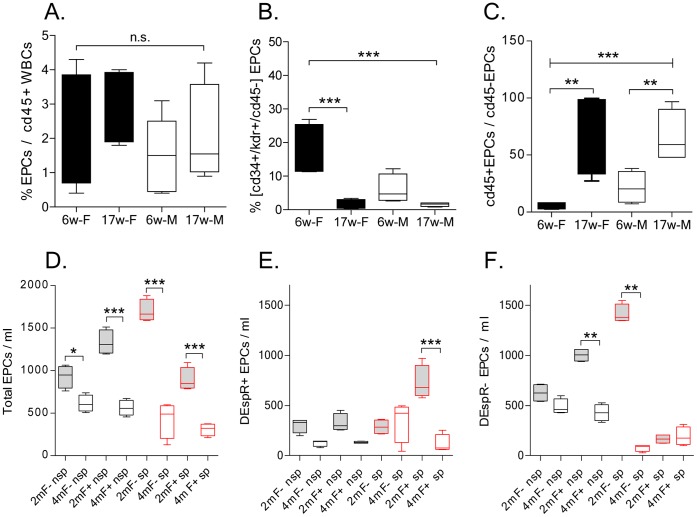
FACS analysis of age- and sex-specific changes in cd34+/kdr+ EPC subtypes. A) Analysis of the ratio of cd34+/kdr+ EPCs to cd45+ white blood cells as %, in males (M) compared to females (F) at 6-weeks (6w) and 17-weeks (17w) of age in non-stroke prone rats. B) Analysis of the ratio of cd45-[cd34+/kdr+]EPCs to total [cd34+/kdr+]EPCs as %, and C) analysis of the ratio of cd45+ to
cd45- [cd34+/kdr+]EPCS in male and female rats at 6- and 17-weeks of age in non-stroke prone rats shown in A. D) Analysis of cd45-[cd34+/kdr+]EPCs per volume (ml) of whole blood in stroke-prone (sp) female rats that are transgenic Tg25+ (F+) and non-transgenic (F-) compared to non-stroke-prone (nsp) Tg25+ and non-transgenic female rats at two pre-stroke time points: 2 months (2 m) and 4 months (4 m) of age. E-F) Analysis of the effects of age (2 m, 4 m), stroke-susceptibility (sp, nsp) and transgenic hyperlipidemia (F+) vs. nontransgenic normolipidemia (F-) on DEspR+ (E) and DEspR- (F) subclasses of cd45- [cd34+/kdr+]EPCs. Data are presented in box-whiskers plot with minimum/maximum boxed and mean ± s.d. delineated; n = 4–5 rats/study group; EPCs, [cd34+/kdr+] freshly isolated EPCs; P-values for one-way ANOVA with Tukey’s all pairwise multiple comparison *, P<0.05; **, P<0.001, ***, P<0.0001, n.s., not significant.